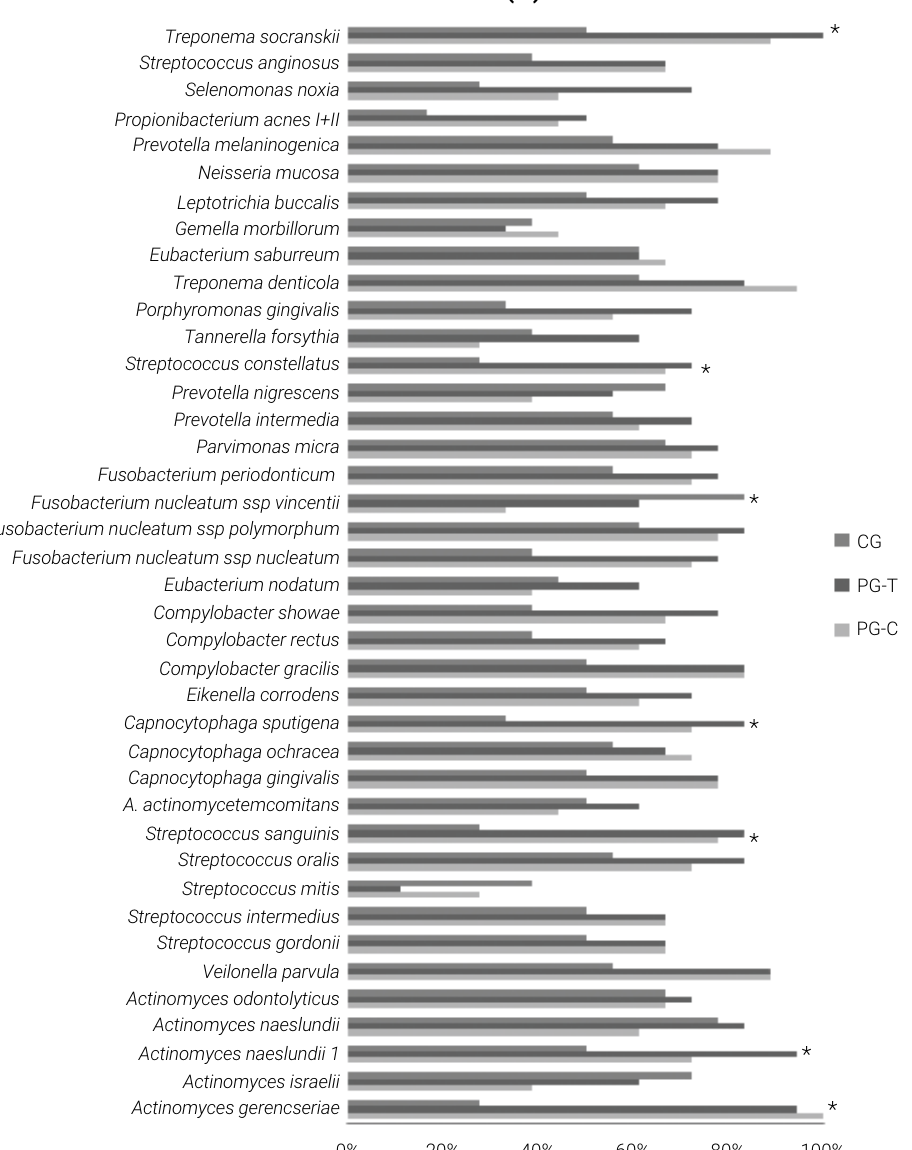
Figure 1. Prevalence of the 40 bacterial species evaluated in the three groups (Healthy – Control, CG; Periodontitis – Test, PG-T and Periodontitis – Control, PG-C). Statistically significant differences among groups were evaluated by Chi-Square Test